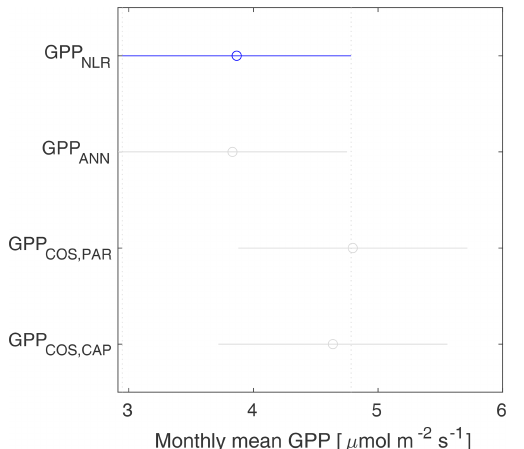
Figure B6. ANOVA test results for monthly GPP data. Gray bars indicate no difference to the reference (blue), and red bars indicate statistical difference to the reference. The results show that all GPPs are statistically the same at monthly scale.